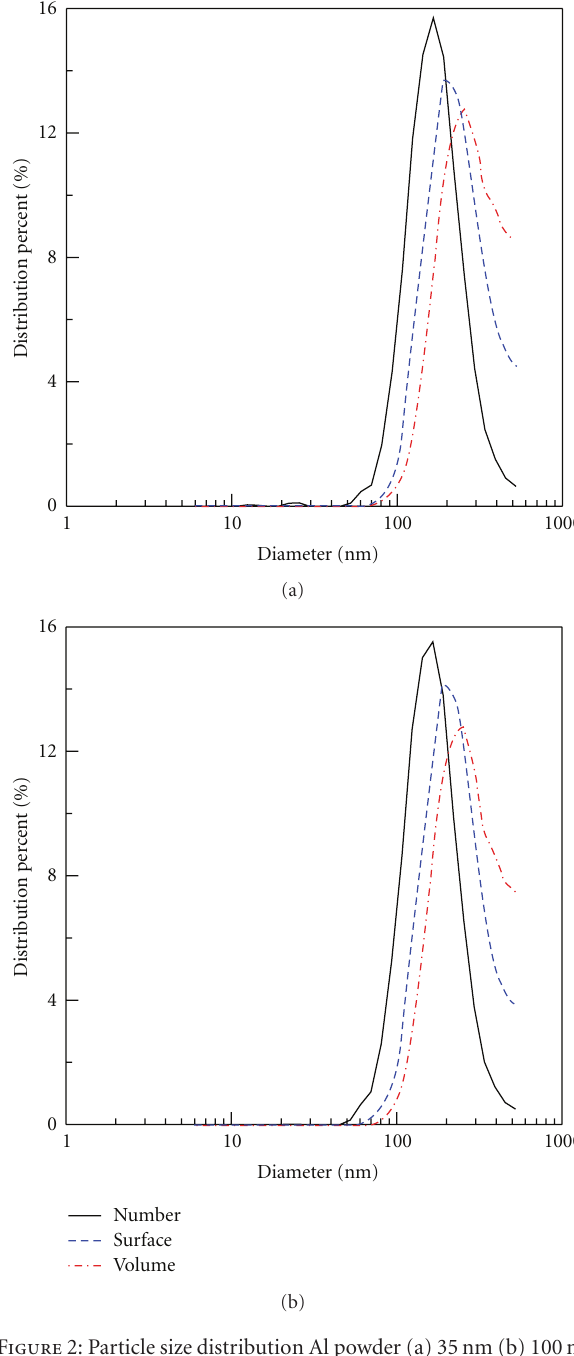
Figure 2: Particle size distribution Al powder (a) 35nm (b) 100nm (measured with EEPS